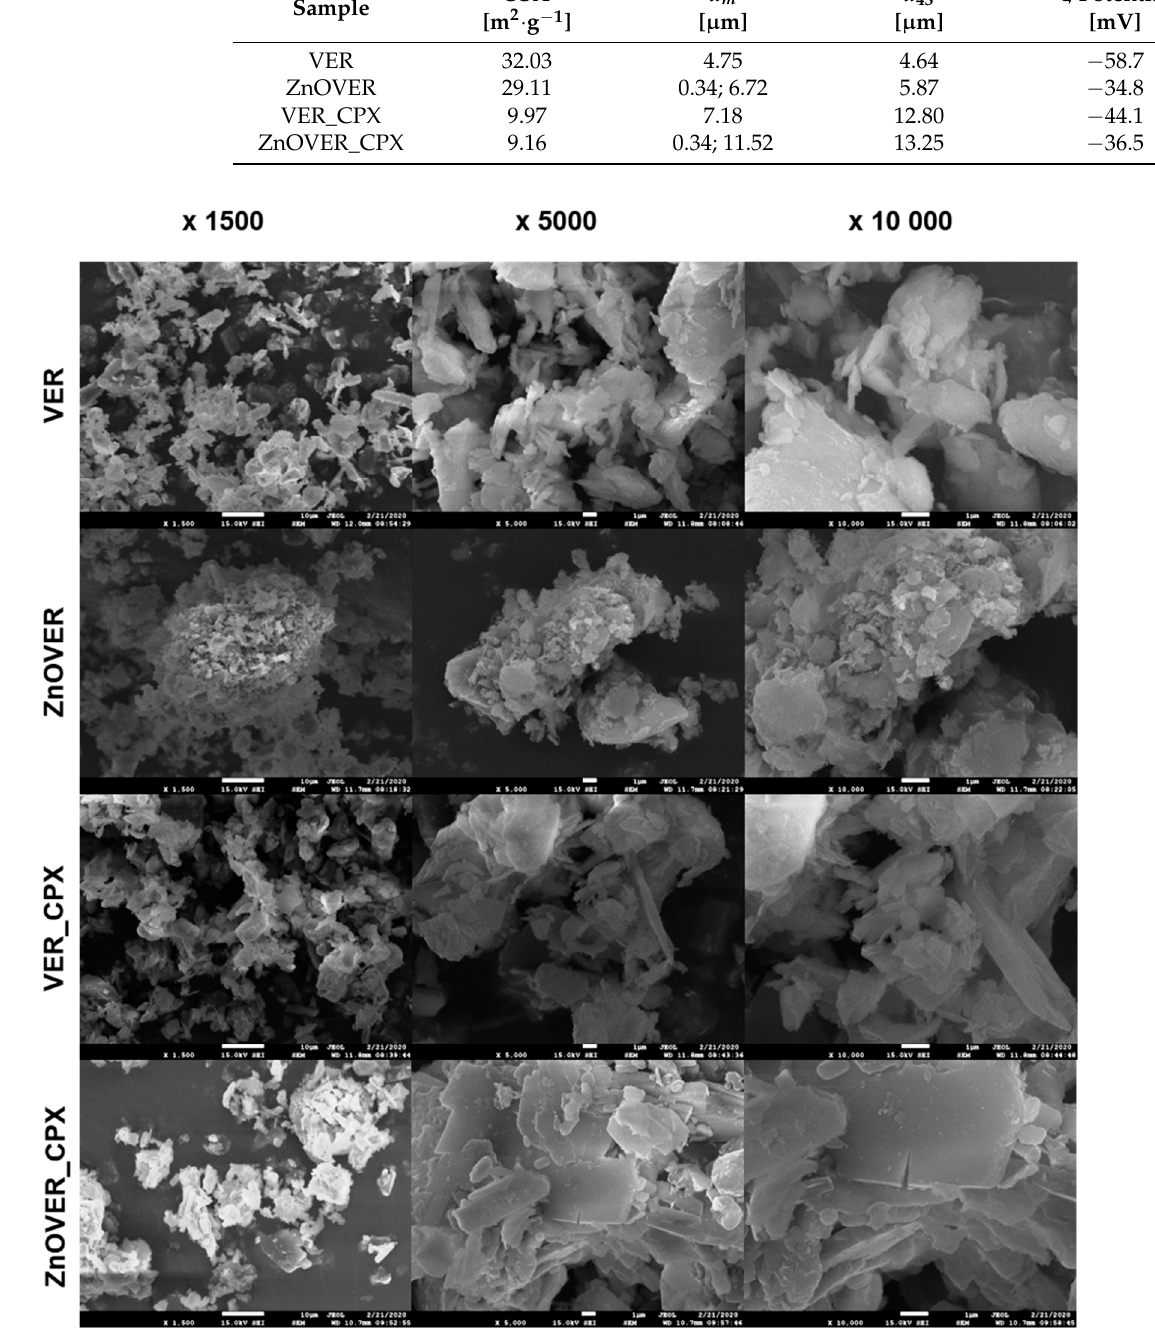
Figure 6. SEM images of VER, ZnOVER, VER_CPX, and ZnOVER_CPX nanofillers (magnification × 1500, × 5000 and × 10,000).